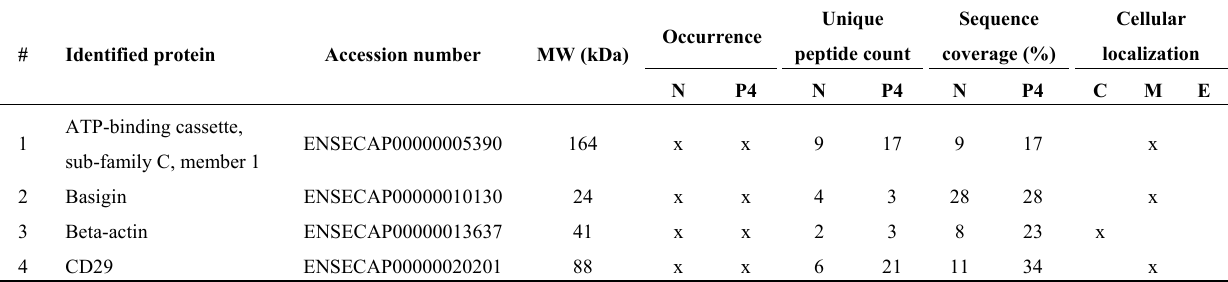
Table 1. Cell surface proteins expressed by RPE cells of horses. Proteins listed were identified by LC MS/MS with a probability score that is significant with p < 0.05 if the confidence score was >30 at a significance threshold for the Mascot result of p ≤